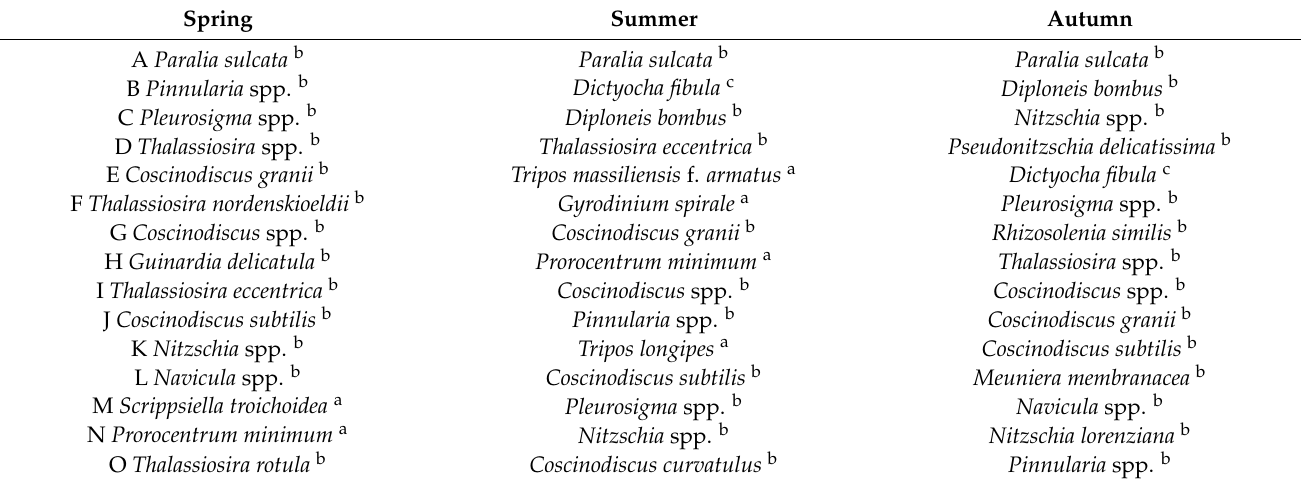
Table 2. Top 15 dominant phytoplankton species during three seasons (spring, summer, and autumn) in the BS and NYS. The alphabetical order in the left column is the order of dominance from largest to smallest.